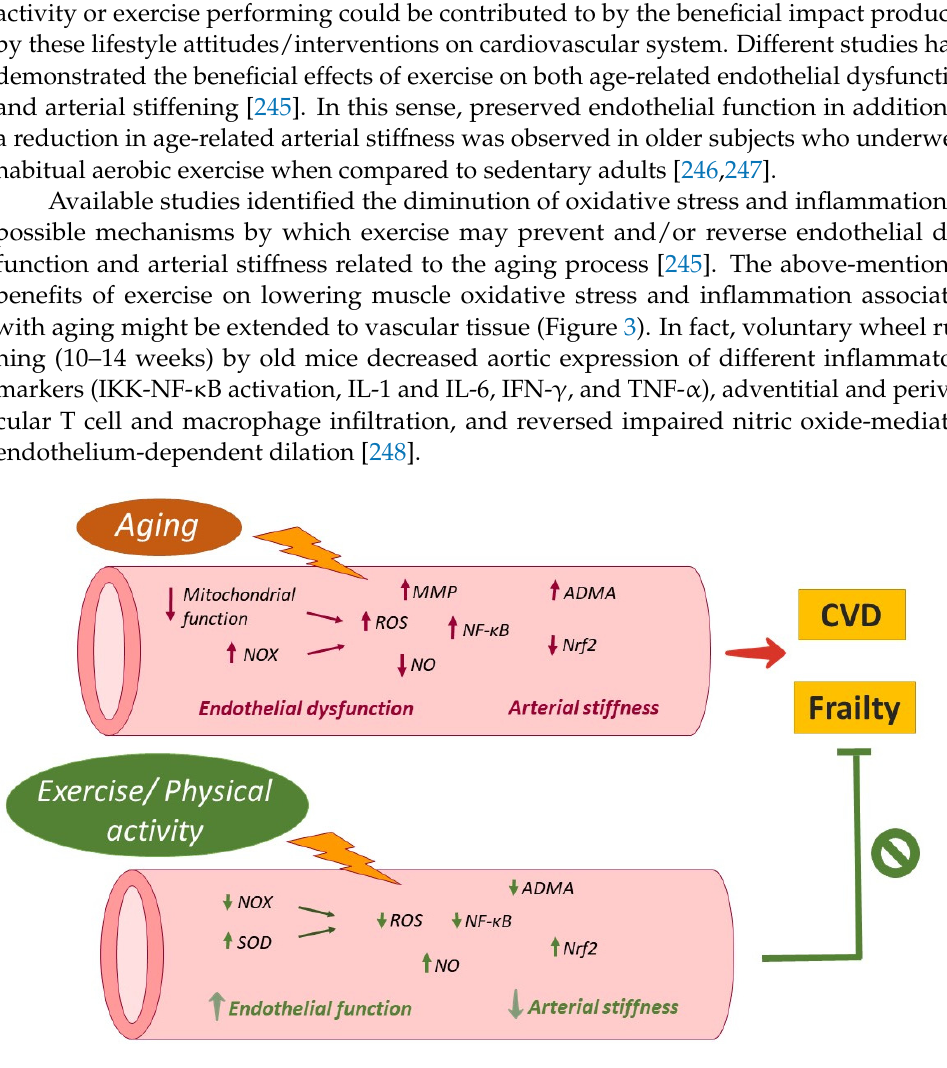
Figure 3. Physical activity/exercise improves different mechanisms through which aging deteriorates vascular function. Endothelial dysfunction and arterial stiffness are two specific vascular pheno- types of vascular aging. The underlying mechanisms of vascular alteration associated with aging includes decreased mitochondrial function and increased expression of vascular NOX, both leading to increased ROS production and further reducing NO availability. Additionally, decreased antioxidant response mediated by Nrf2, increased MMP, reduced SOD activity, enhanced inflammatory mediators, NF- κ B, and increased levels of the NO synthase endogenous inhibitor, ADMA, contribute to increasing the risk of developing cardiovascular disease and age-related frailty. Exercise/physical activity improves endothelial function and arterial stiffness through reducing inflammatory and oxidative damage signaling in vascular tissue together with an increase in antioxidant enzymes and NO availability. These improvements prevent or delay the onset of frailty and decrease clinical cardio- vascular disease. ADMA: asymmetric dimethylarginine, CVD: cardiovascular disease, NF- κ B: nuclear transcription factor-kappa B, NO: nitric oxide, NOX: nicotinamide adenine dinucleotide oxidase, Nrf2: nuclear erythroid-2 like factor-2, ROS: reactive oxygen species, SOD: superoxide dismutase. Furthermore, data obtained from human studies have reported a decreased content of nitrotyrosine, a marker of nitrosative stress, in endothelial cells derived from exercising el- derly subjects when compared to the sedentary peer group. In addition, exercise was related to reduced endothelial expression of p47(phox) subunit of the oxidant enzyme, NADPH oxidase, and the redox-sensitive inflammatory transcription factor, NF- κ B (p65 subunit). By contrast, the expression of SOD2 and the activity of endothelium-bound extracellular SOD (SOD3) were greater in the exercising group of older subjects [249]. On the other hand, dif- ferent studies from animal models and humans suggested that exercise training increases NO production, which may play a causal role in the reduction in arterial stiffness risk [250]. Shimomura et al. further supported this observation. A reduction in ADMA elicited by aer- obic exercise increased circulating NOx (a surrogate of NO production) and was associated with a decrease in arterial stiffness in both middle age and older men and women [251]. In addition, age-related BH4 deficiency in soleus muscle arterioles was restored by exercise. BH4 restoration prevented eNOS uncoupling and stimulated NO availability [252]. It is noteworthy to mention the crosstalk between muscle derived myokines, induced by exercise, and the vascular bed [96]. In line with this, different studies have suggested that irisin may regulate vascular endothelial function [253]. Furthermore, the study car- ried out by Fujie and colleagues further supports these observations, since they reported that after 8 weeks of aerobic exercise training, plasma apelin concentrations increased along with plasma NOx levels in middle-aged and older subjects. Meanwhile, a concom- itant decrease in arterial stiffness was detected in these subjects [254].